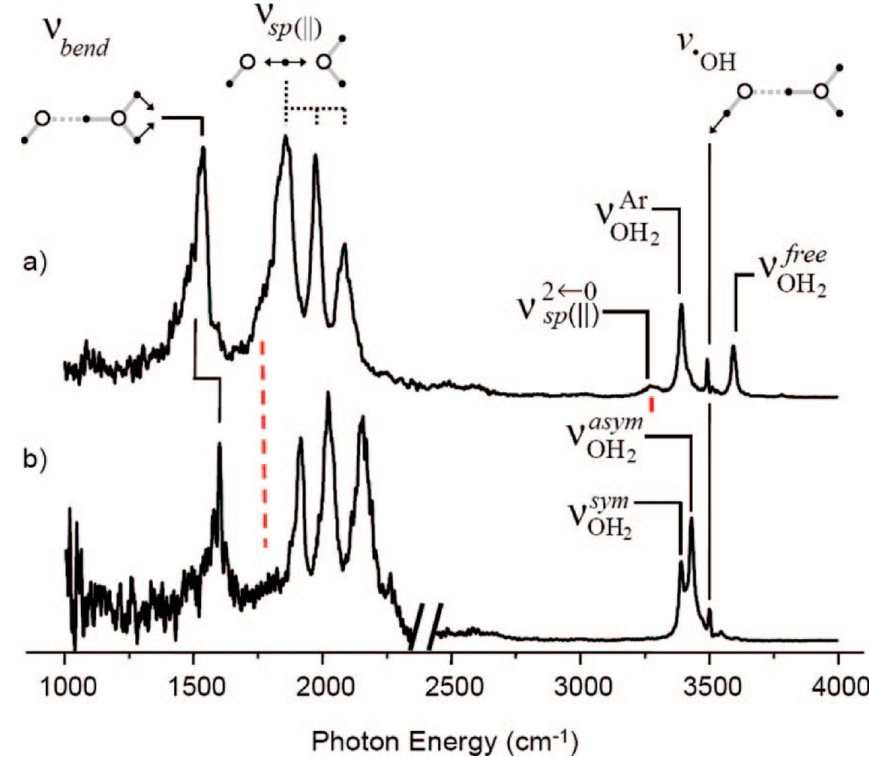
Figure 24. Vibrational predissociation spectra of ( a ) (H 2 O) 2+• •Ar, monitoring the loss of Ar and (b) (H 2 O) 2+• •Ar 2 , monitoring the loss of two Ar species per molecule for excitations above 2400 cm − 1 and the loss of one Ar in the low-energy region. Schematic displacement vectors are included to illustrate qualitative assignments of observed features. The subscript sp (ll) refers to the parallel displacement of the bridging proton along the heavy-atom (O-O) axis. The superscripts sym and asym denote, respectively, the symmetric and asymmetric stretches of dangling OH groups of the H 3 O + moiety, each of which is bound to an Ar atom in the n = 2 system. The subscript • OH refers to the OH stretch on the hydroxyl moiety. Calculated anharmonic values for υ sp (ll) and 2 υ sp (ll) are shown with dashed red lines. Figure adapted from [99] with permission. Copyright 2009 American Chemical